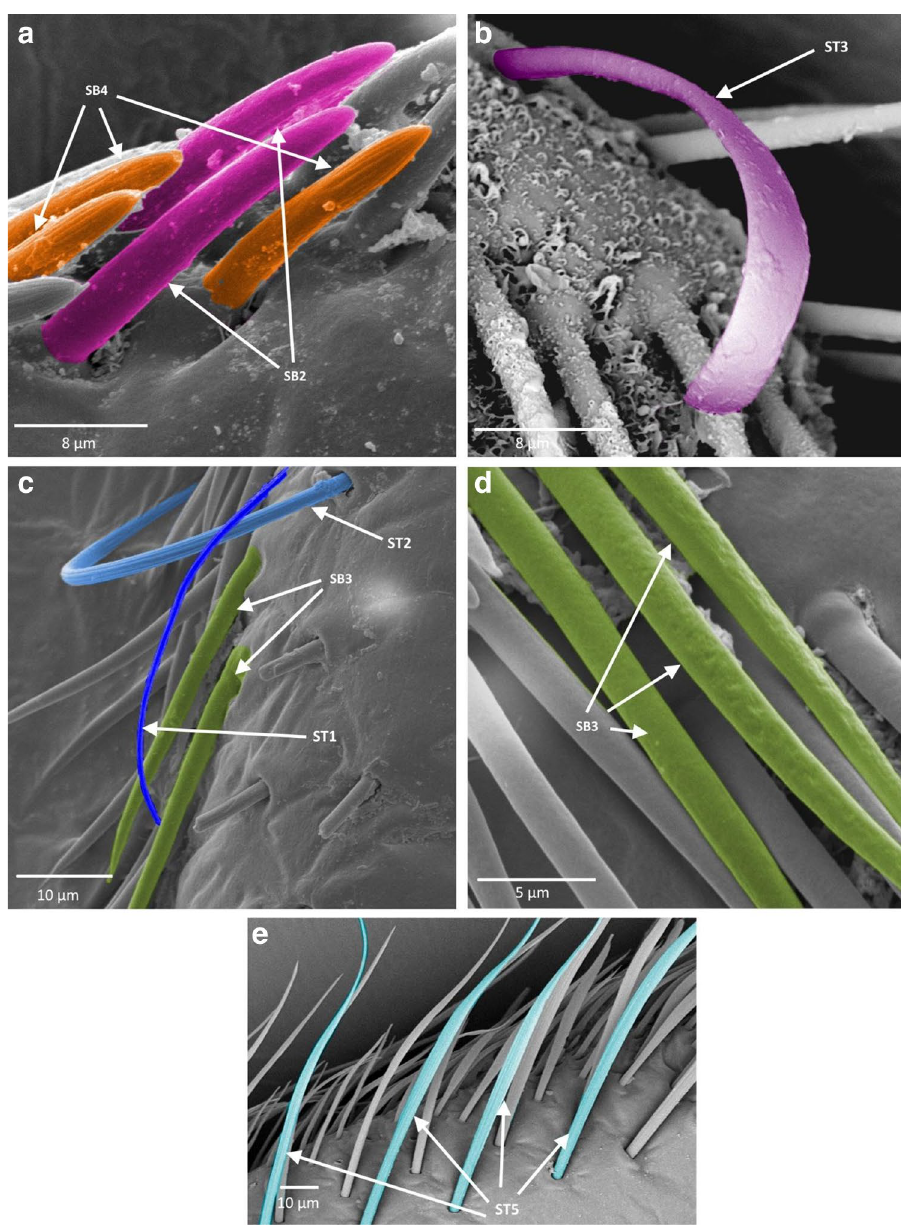
Figure 6. Antennal sensilla; ( a ) Cryphocricos montei, ( b ) Heleocoris strabus, ( c ) Limnocoris asper, ( d ) Limnocoris pusillus, ( e ) Limnocoris volxemi . ST sensilla trichodea, SB sensilla